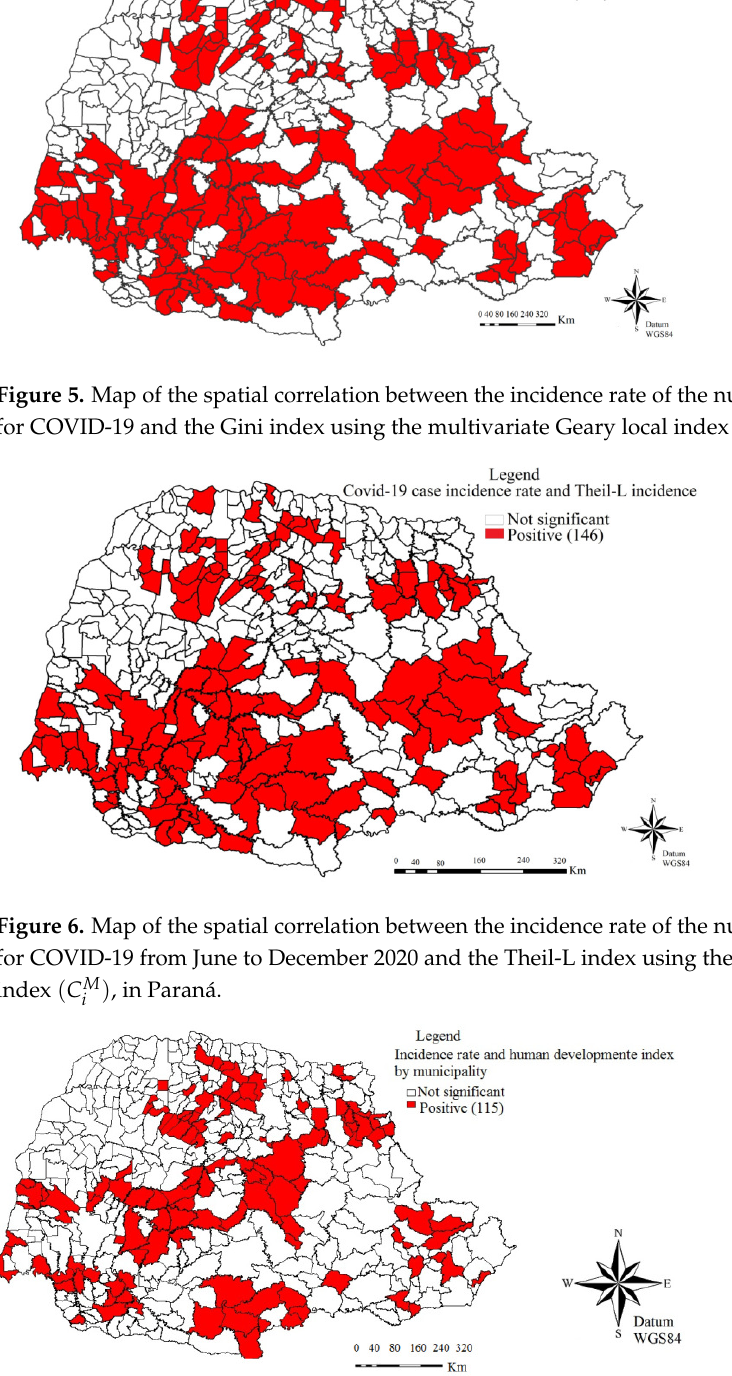
Figure 7. Map of the spatial correlation between the incidence rate of the number of confirmed cases for COVID-19 and the MHDI for the months of June 2020 to December 2020 using the local Geary ) , in multivariate index ( C M i